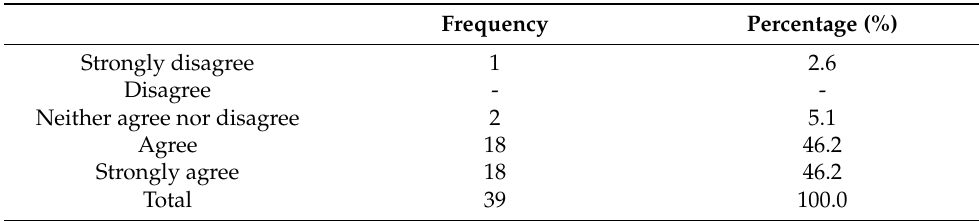
Table 10. Frequency and percentage units regarding respondents’ agreement with the establishment of Hub ( N = 39). Frequency Percentage (%)